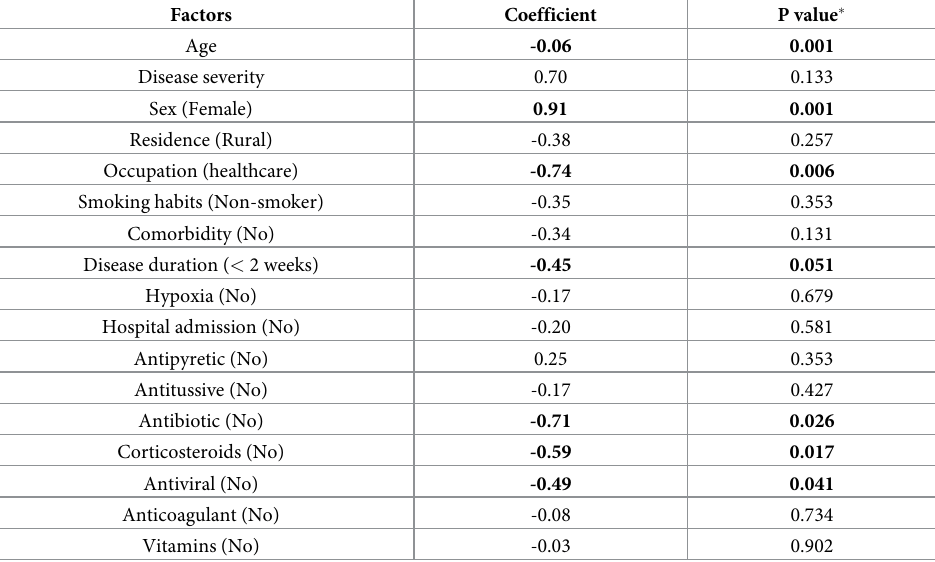
Table 3. Factors associated with severe post COVID